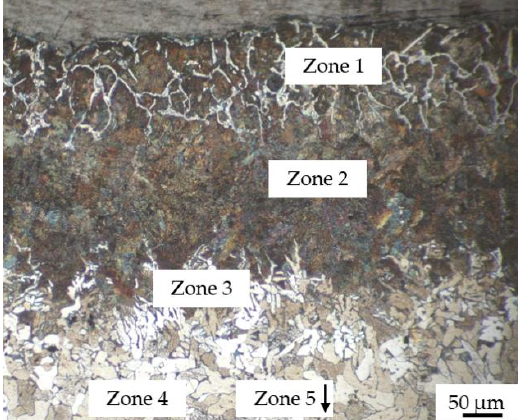
Figure 12. OM magnification of the top of the sample sintered using graphite foil with a 0.5 µm tick Ti coating: area where carburization thickness is more significant.